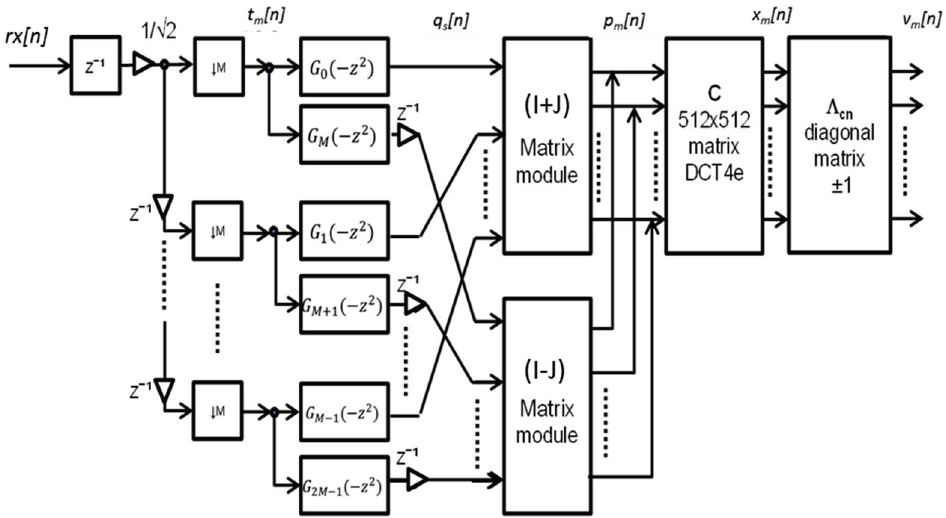
Figure 1. General block diagram of the used Wavelet-OFDM